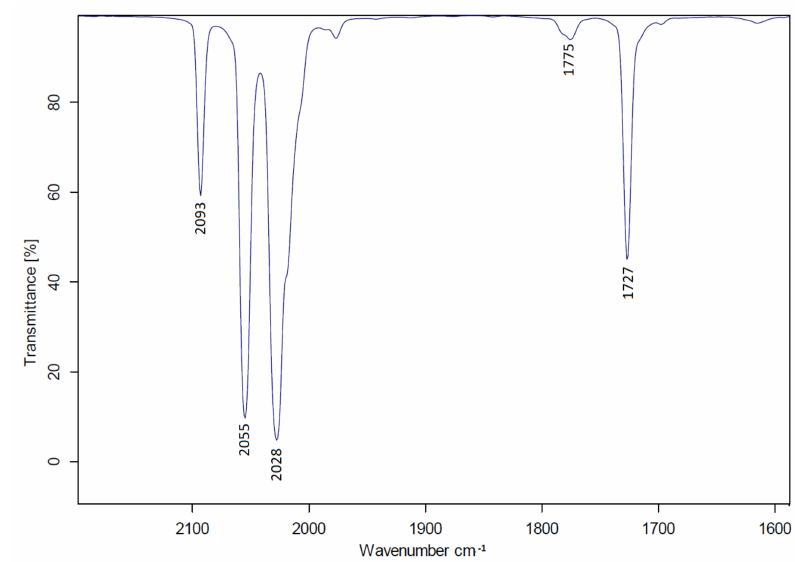
Figure 1. IR spectrum of compound 2 recorded in cyclohexane.